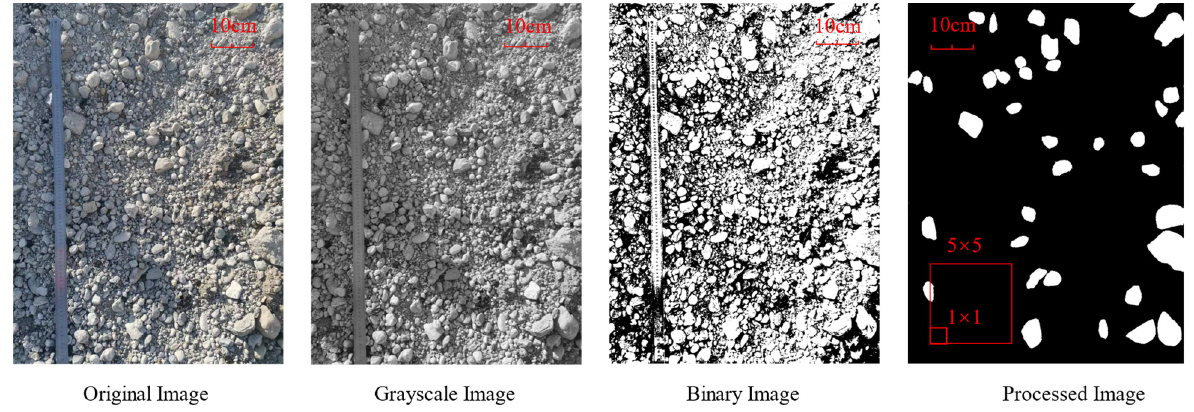
Figure 1. Digital image processing steps of the in situ SRM image.